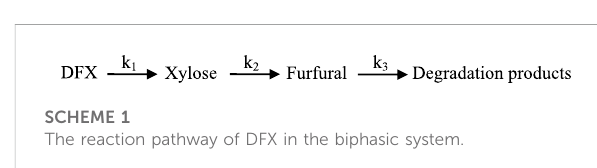
SCHEME 1 The reaction pathway of DFX in the biphasic